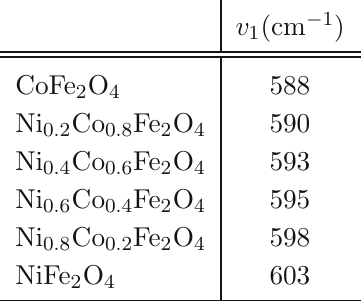
Table 3 The IR spectral analysis for the studied